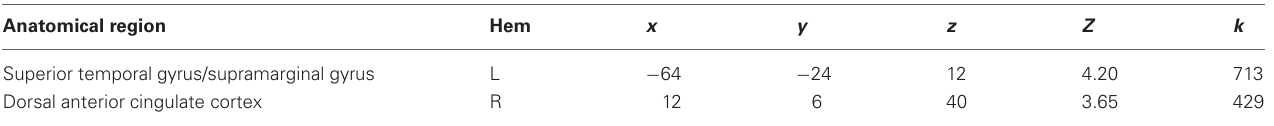
Table 2 | MNI coordinates and response intensity of cluster peaks identified in which brain response for the Animate > Random contrast varied significantly as a function of OXTR methylation p < 0 . 05 (corrected).